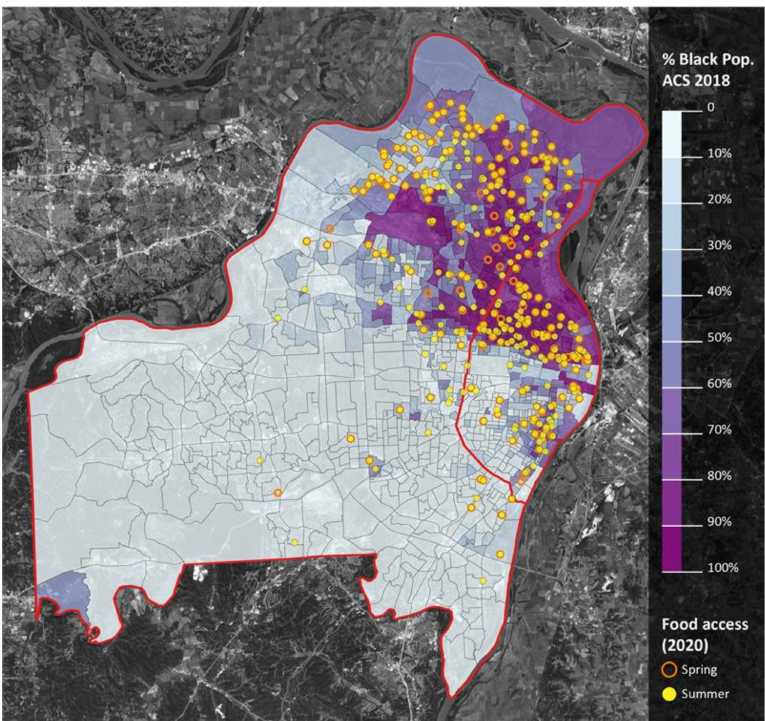
Figure 7. Percent black population and meal access. Notes: St. Louis City is the area east of the red line. St. Louis County is the area west of the red line. Darker shades of purple represent greater proportions of Black residents. Orange circles represent spring meal sites; yellow dots represent summer meal sites.